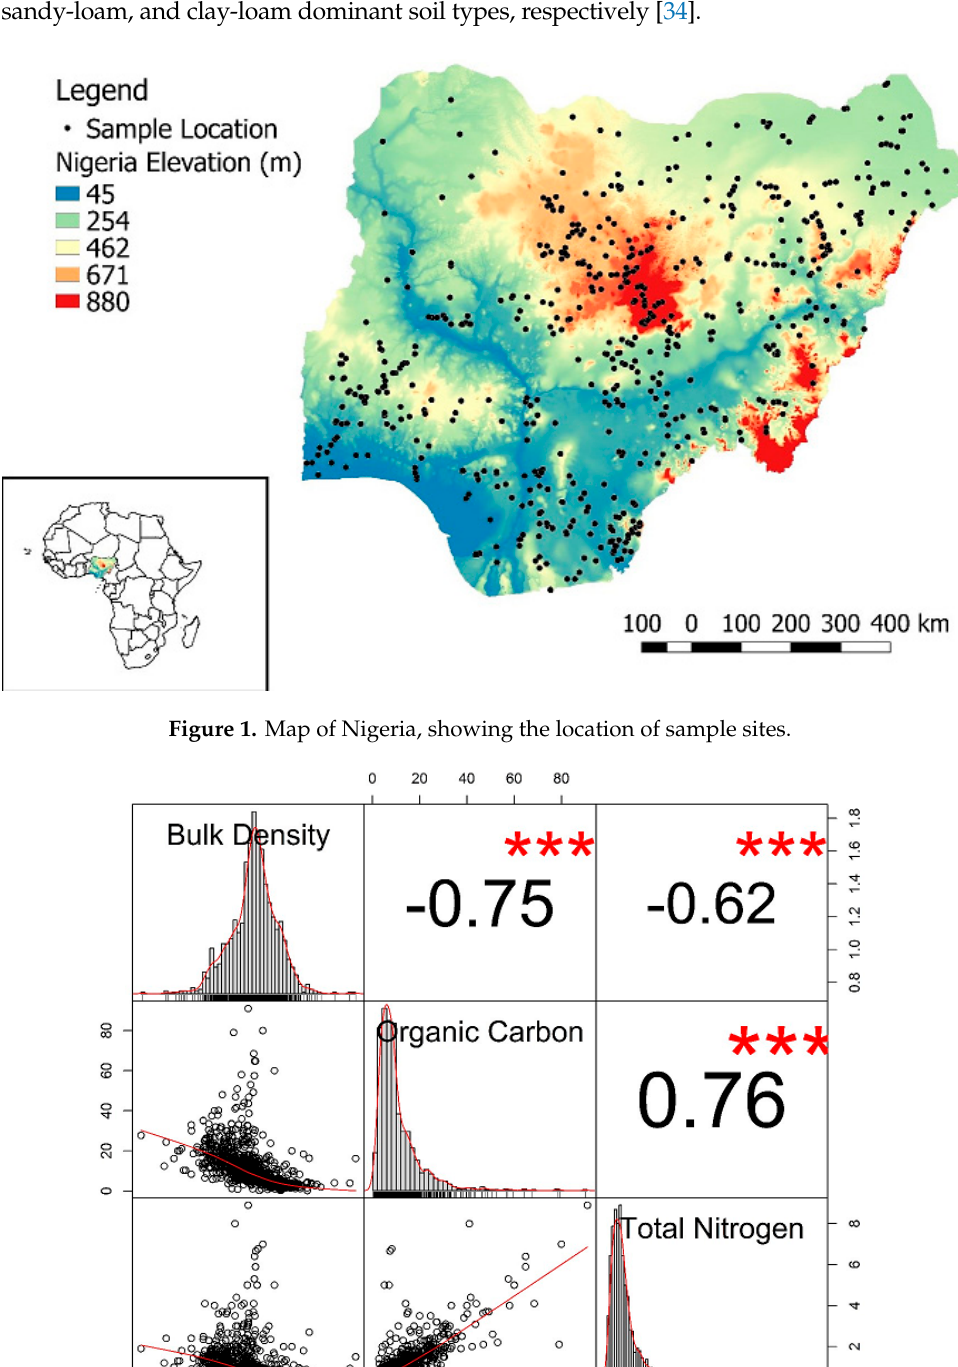
Figure 3. Direct and cross-experimental variograms of the original soil health indicators (SHIs): BD = bulk density (g/cm 3 ); TN = total nitrogen (g/kg); and OC = organic carbon (g/kg) (semivariance is expressed as units of each SHI, significance levels (*** p < 0.001) ).